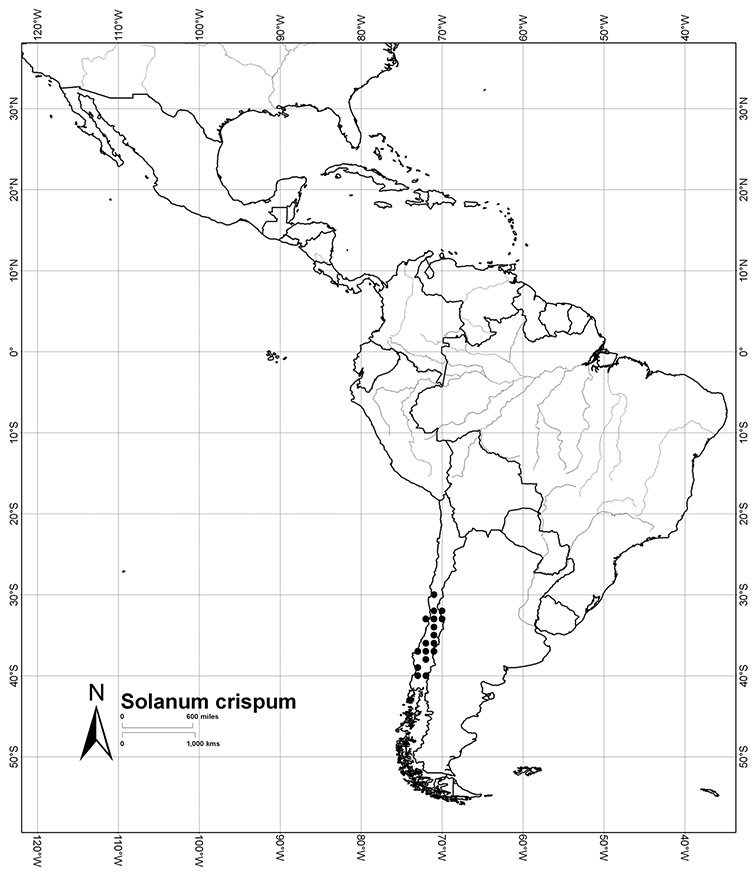
Distribution of Solanum crispum Ruiz & Pav.